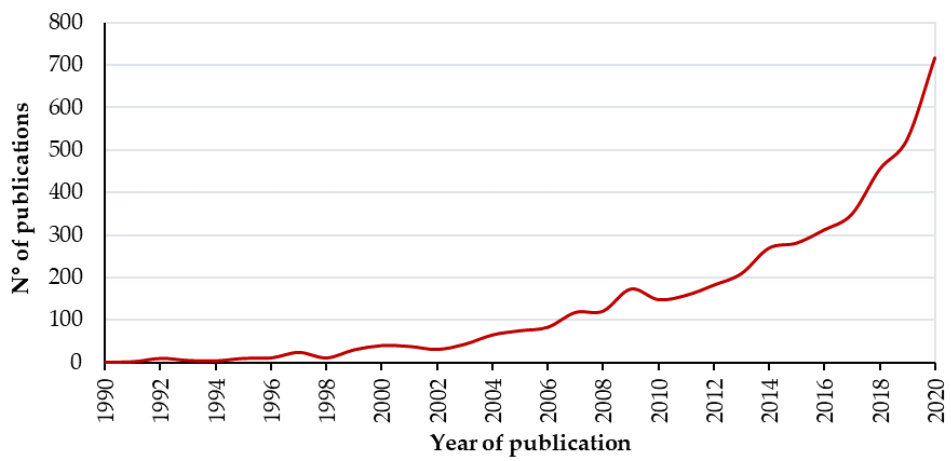
Figure 1. Evolution of the number of works published between 1990 and 2020. Source: Scopus da- tabase.